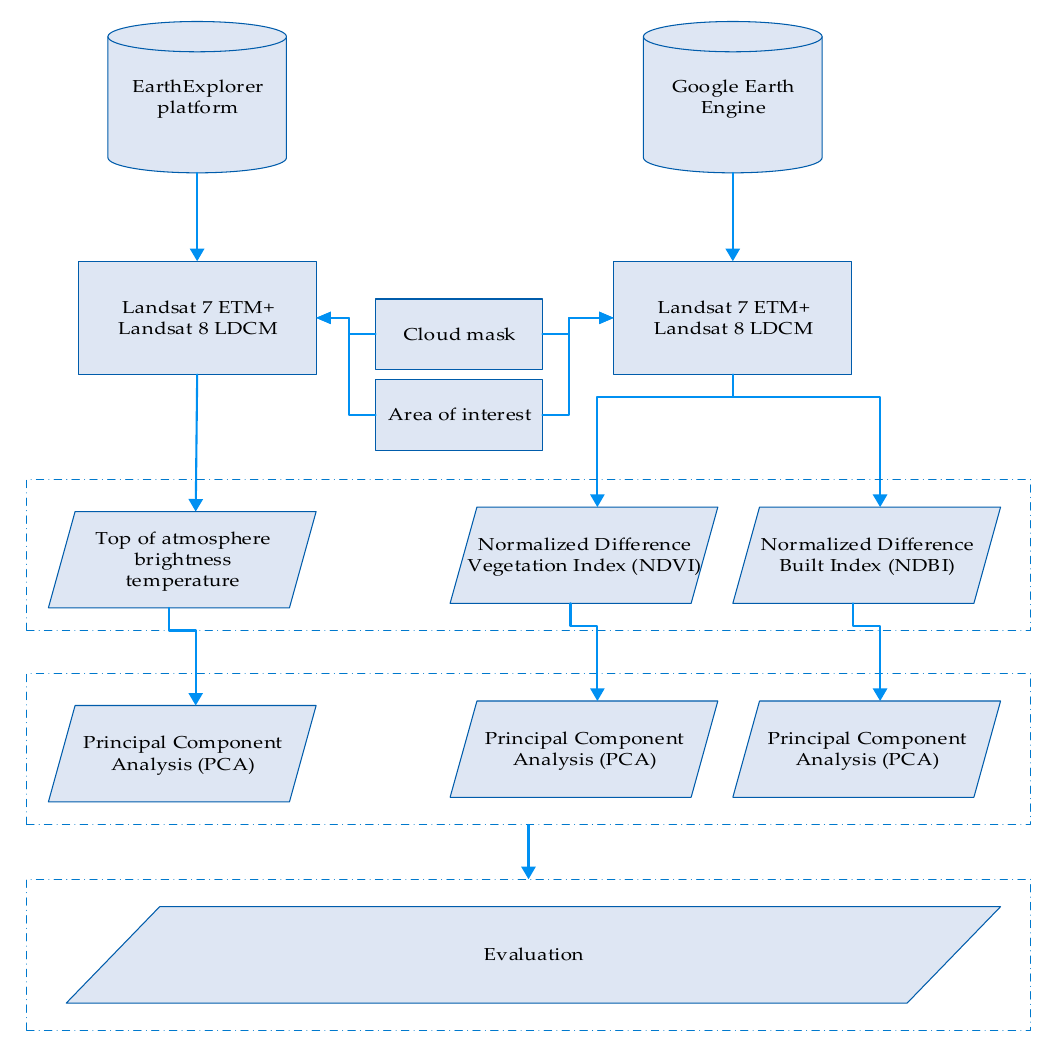
Figure 1. Overall methodology of the current study.